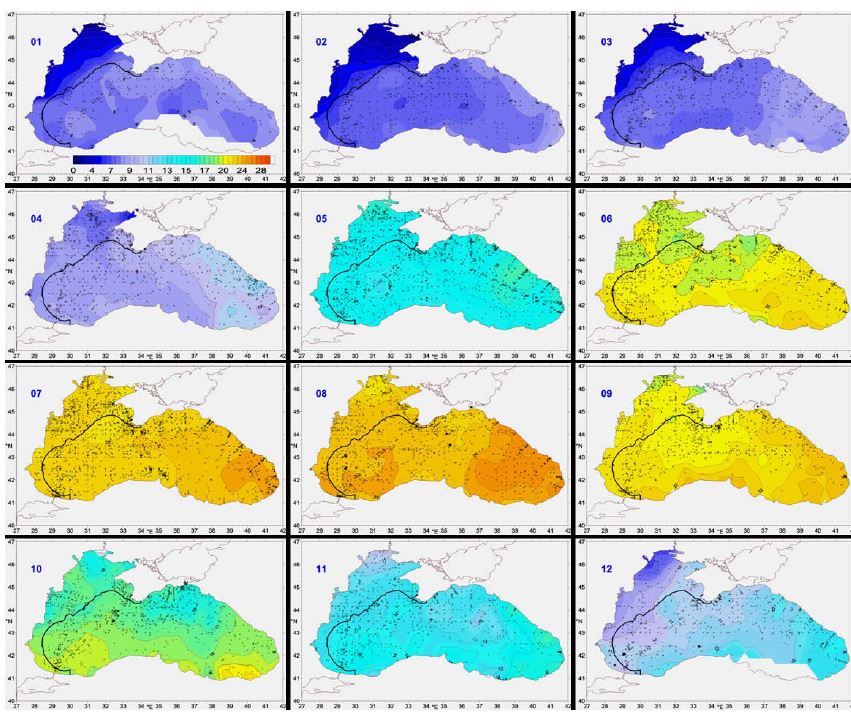
Fig. 4. Monthly charts of mean Sea Surface Temperature averaged over the 20th century.